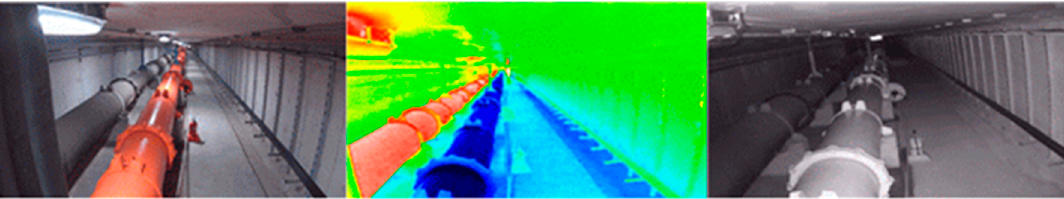
Figure 1. Underground utility tunnel CCTV red-green-blue (RGB, left), thermal image (middle), and no-light image (right).